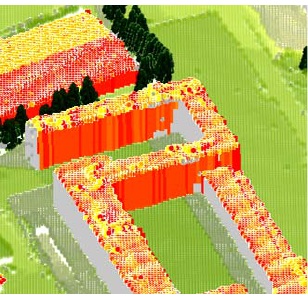
Figure 9. Detail of the 3D solar radiation model showing façades partially in shadow (June, the 6 st , 9